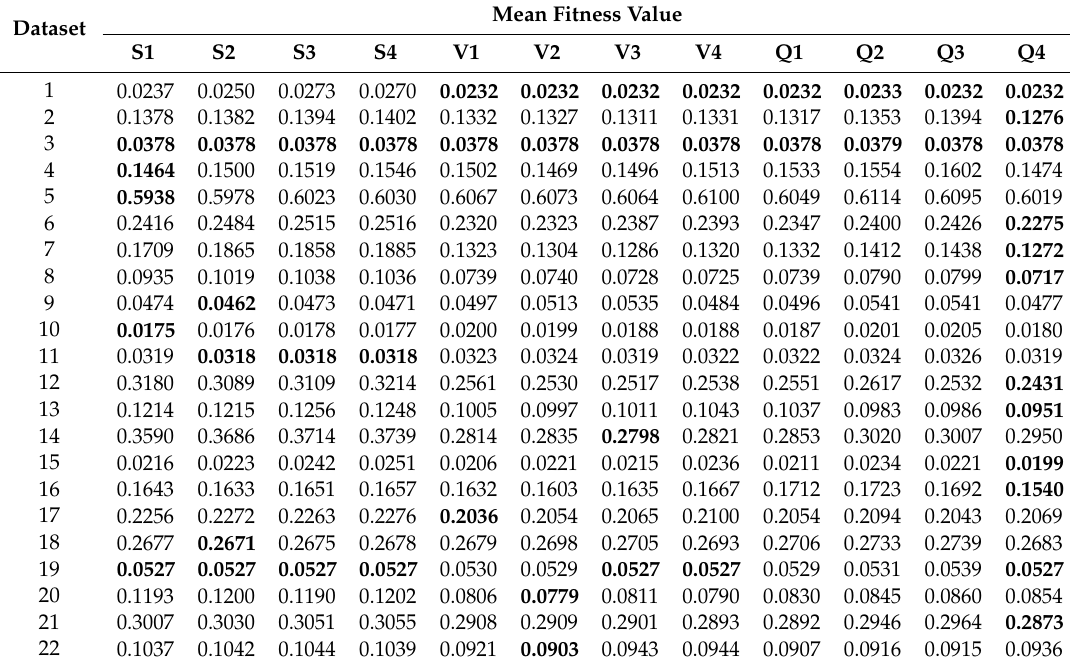
Table 5. Experimental result of the mean fitness value of the proposed algorithms.